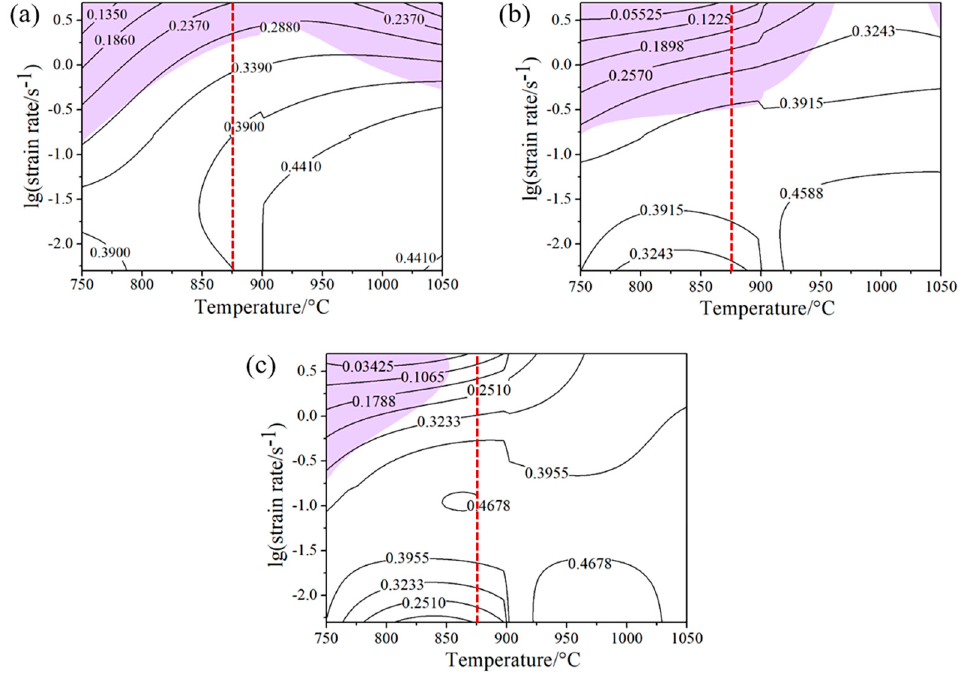
Figure 5. Processing maps of Ti555211 sample at the various strains: ( a ) 0.3; ( b ) 0.6; ( c ) 0.9.